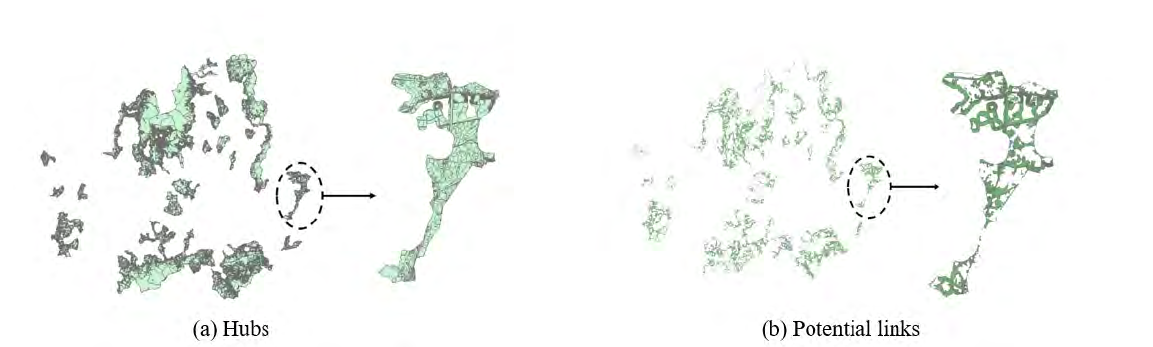
Figure 2. The extracted hubs, potential links, and links